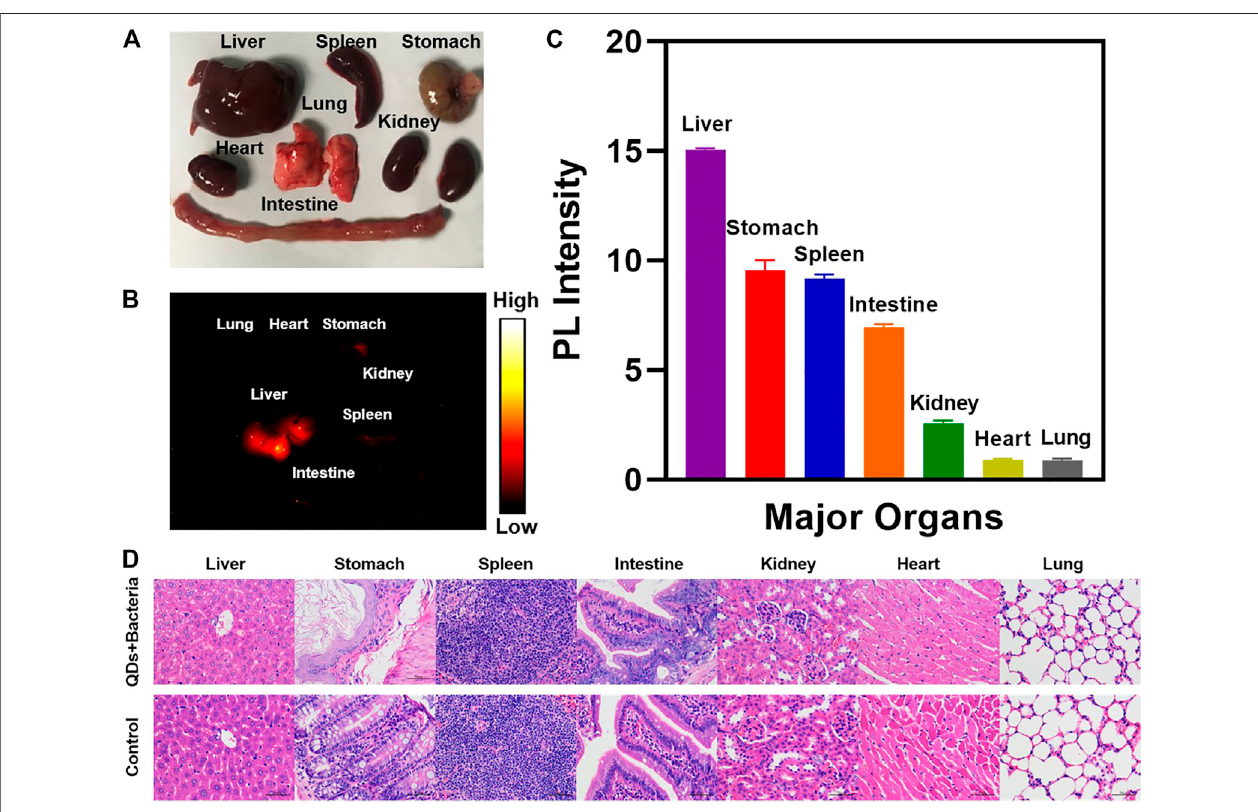
FIGURE5|(A) Photographofmajororgansharvestedfromtheinfectednudemouse. (B) NIR-IIimageofmajororgansharvestedat3 weekspost-infection. (C) PL intensity measured from the NIR-II image of the harvested major organs. (D) H&E staining micrographs of representative major organ tissues of the infected nude mice compared with a control group (magni fi cation: ×